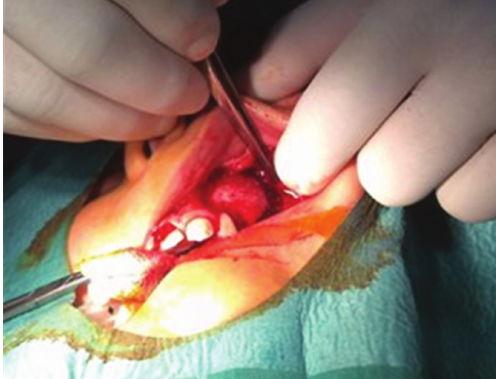
Figure 8: Complete cyst enucleation.